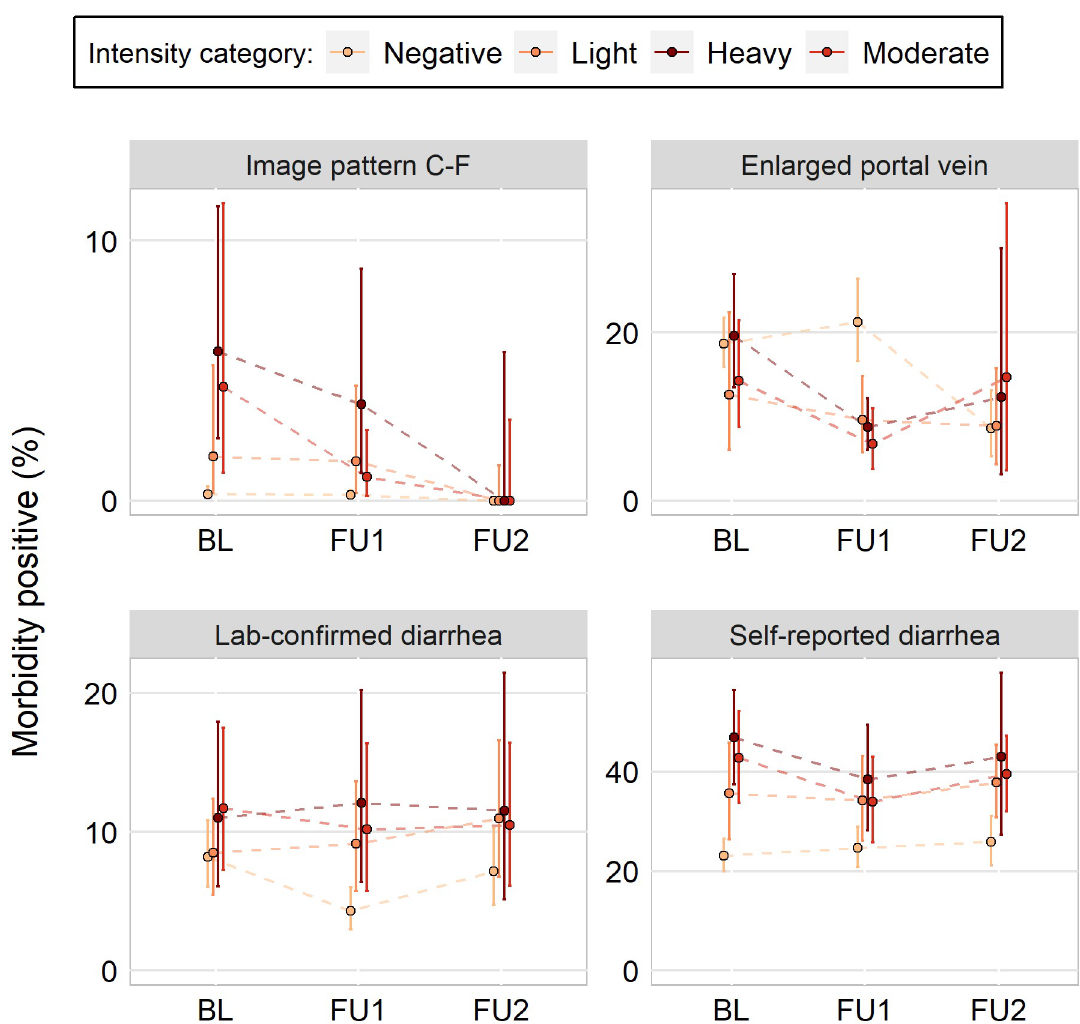
Fig 3. Line graphs of Schistosoma mansoni -related morbidity percentages, broken down by intensity category, across three surveys (baseline, BL; follow-up 1, FU1; follow-up 2, FU2). Participants were enrolled between 2003 and 2008 in Mali, Niger, Tanzania, and Uganda. Clustering by school accounted for in 95% confidence bands. Infections were assessed by Kato-Katz stool examination.